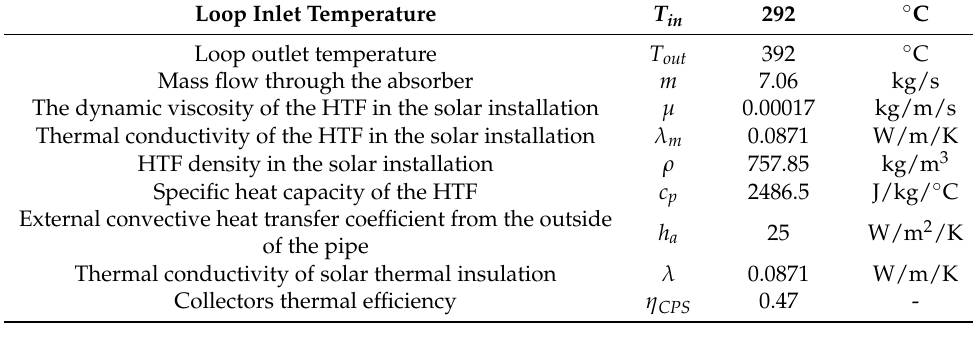
Table 2. Operation parameters of the Solar Thermal Power Station of the south of Spain.